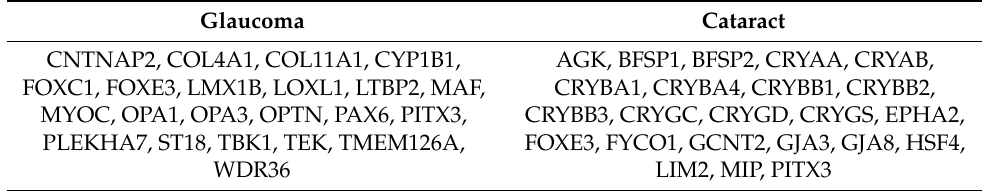
Table 2. Mainz Childhood Glaucoma Gene